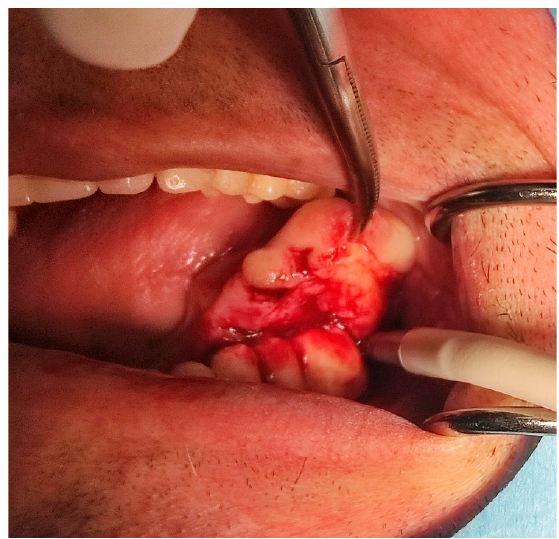
Figure 2. Orthopantomogram of the lower jaw of the patient.